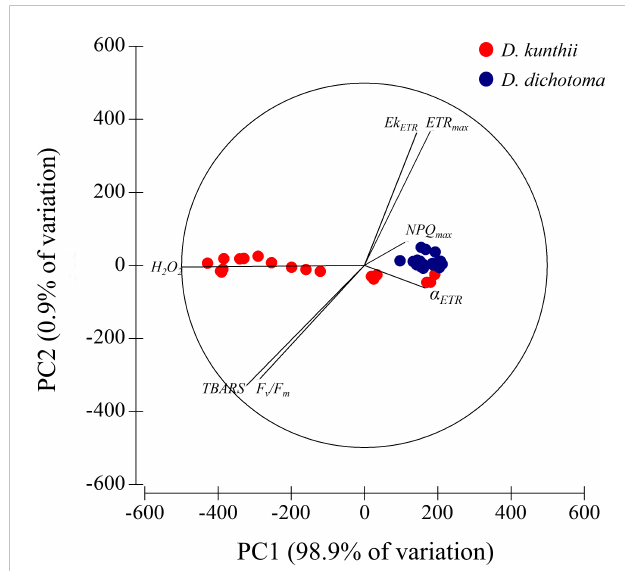
FIGURE 5 Principal component analysis linked to photosynthetic ( F v /F m , a ETR , ETR max , Ek ETR , and NPQ max ) and oxidative stress (H 2 O 2 and thiobarbituric acid reactive substance) parameters in both times (3 and 7 days), measured in each species: D. kunthii (Sp1) and D. dichotoma